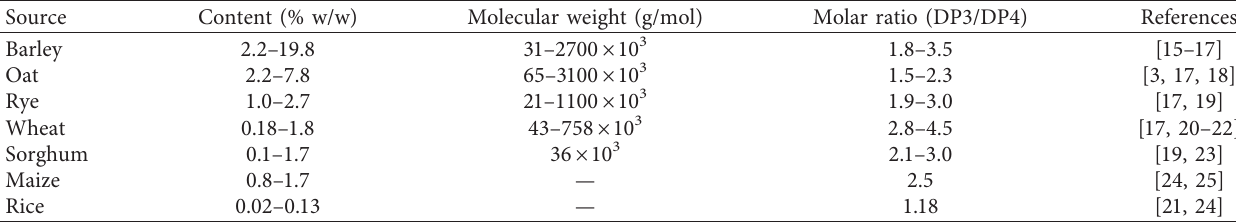
Table 1: Common sources and molecular characteristics of cereal β